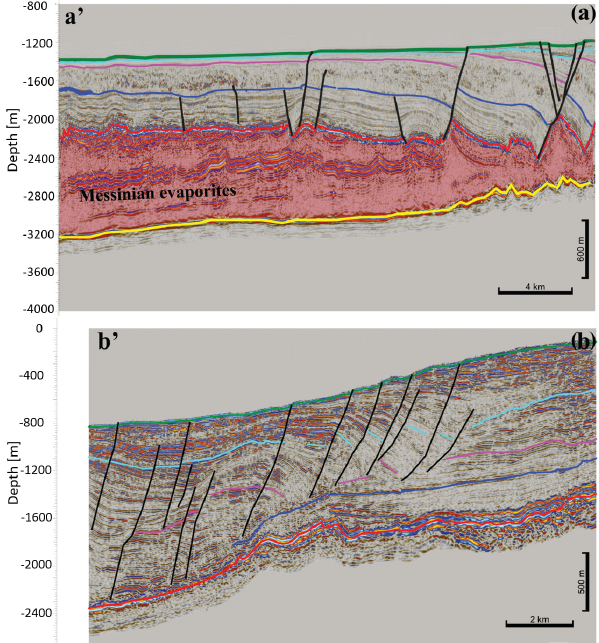
Figure 10. Seismic cross sections illustrating the difference be- tween Group I (a-a (cid:48) , Sara–Mira survey) located west of the salt wedge and Group II (b-b (cid:48) , Yam–Hadera survey) located on the con- tinental slope east of the salt wedge (Messinian evaporites are miss- ing). Note that the faults of Group II do not displace the top unit 2 horizon (unit 2 in blue). Location in Fig. 9.